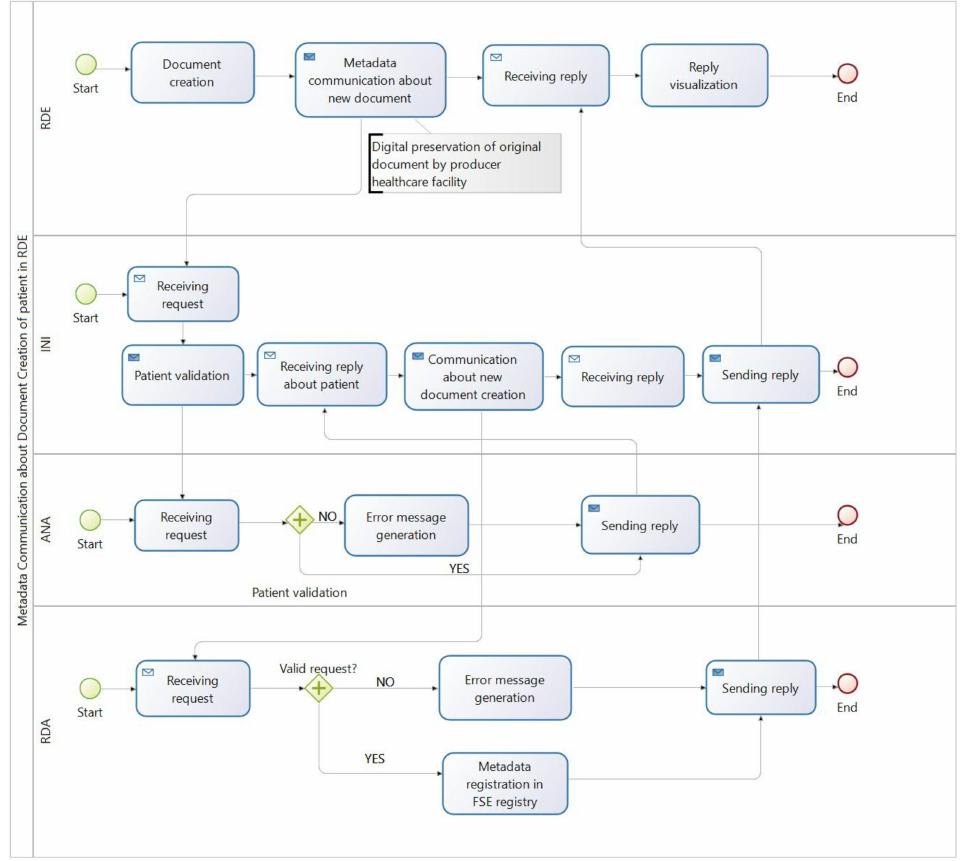
Figure 4. Metadata communication process on the creation of a new document for a patient in the